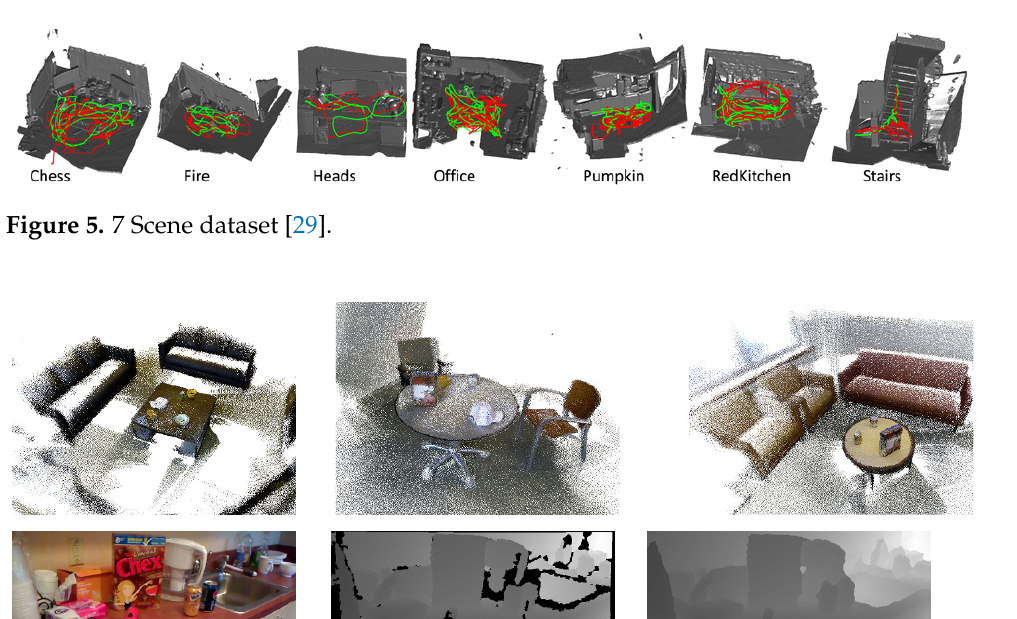
Figure 4. RGB-D TUM Dataset—frames taken from the two sequences.